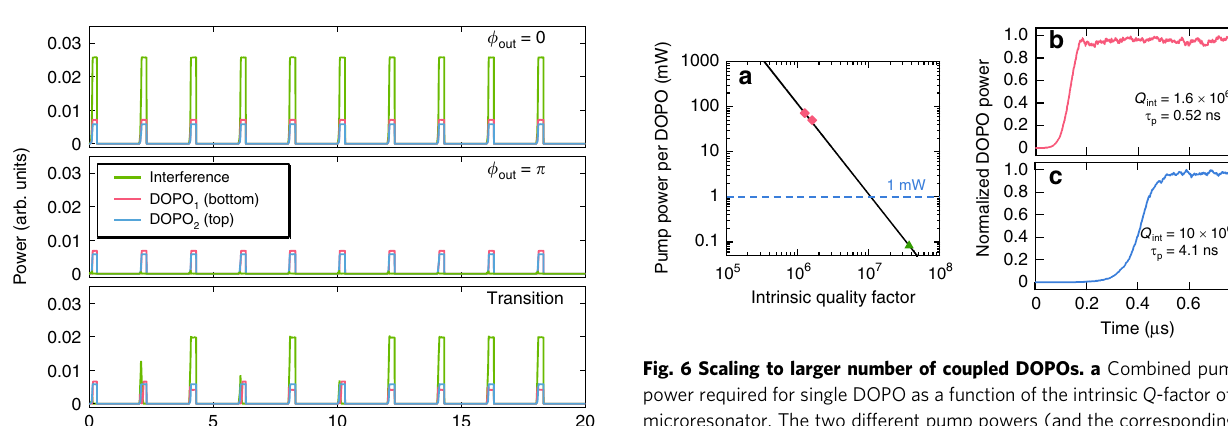
Fig. 4 Phase characterization of coupled DOPOs. Temporal ensemble of interference measurements of the combined DOPOs (green) along with measurements of DOPO 1 (red) and DOPO 2 (blue). Inset shows the phase chart of the coupling phase ϕ c . We indicate the coupled DOPO operation regime for in-phase (pink), out-of-phase (blue), and transition regime (gray). a Constructive interference (in-phase, ϕ out = 0) is observed for a heater power of 48.3 mW. b Destructive interference (out-of-phase ϕ out = π ) is observed for a heater power of 54.2 mW. c Transition from in-phase to out-of-phase operation for heater power of 50.2 mW. For clarity, DOPO 2 and the interference are offset from DOPO 1 in power by 40 and 80, respectively.